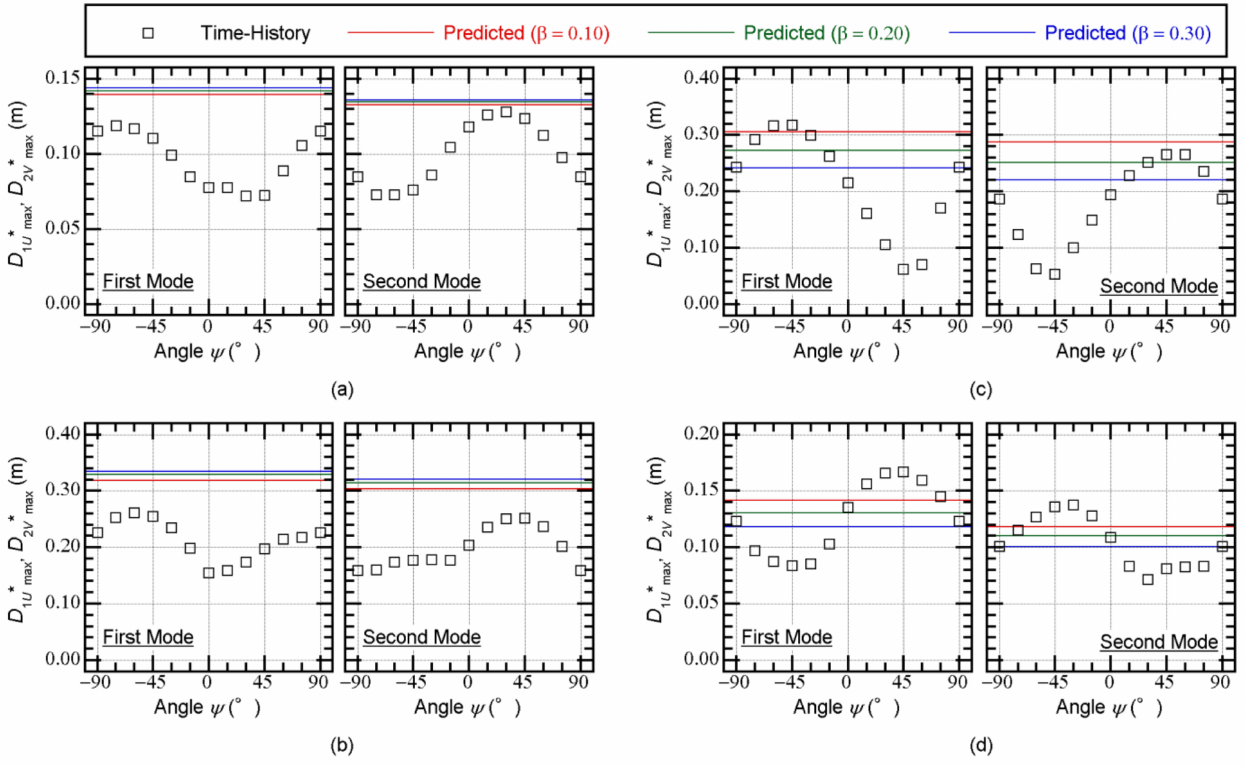
Figure 39. Peak equivalent displacements of the first two modes for various directions of seismic input